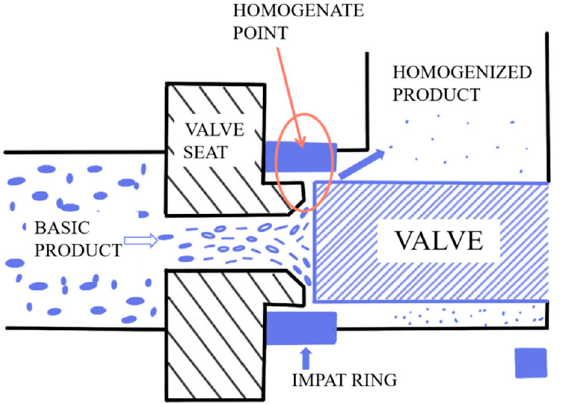
Figure 1. Working principal diagram of the homogenizer.